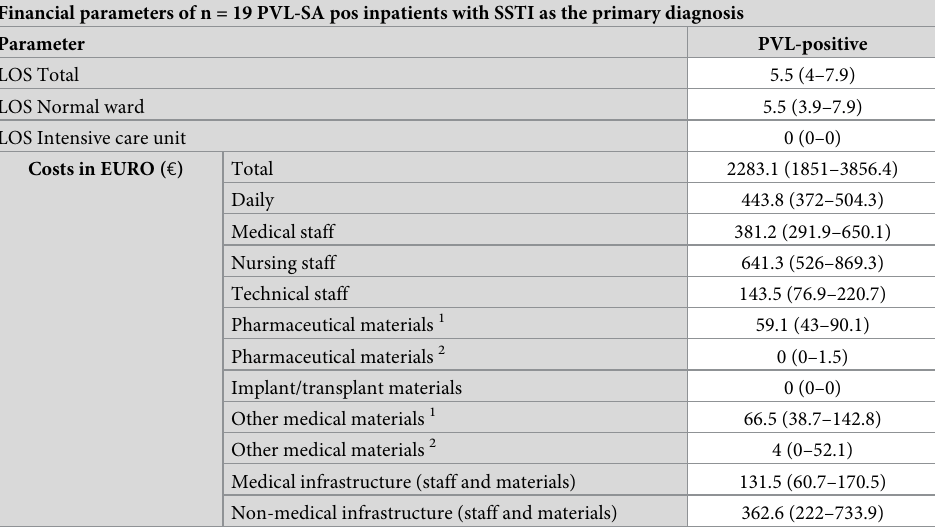
Table 2. Financial parameters of inpatient treatment of PVL-SA infections with SSTI as the primary diagnosis. Financial parameters of n = 19 PVL-SA pos inpatients with SSTI as the primary